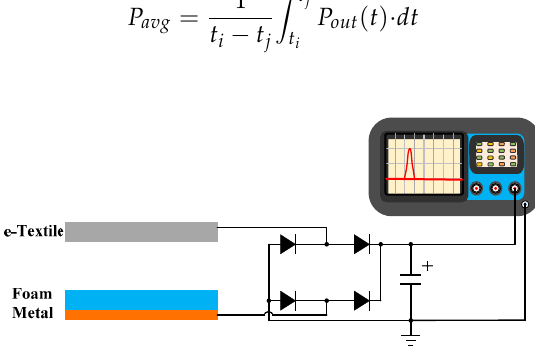
Figure 3. System setup with rectifier and display.